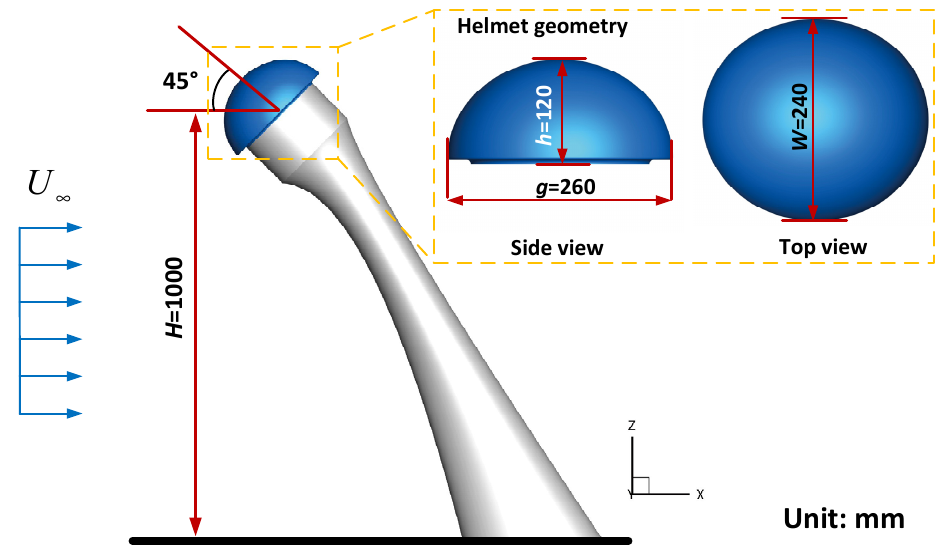
Figure 1. The simplified helmet model with geometrical dimensions used in CFD simulations.